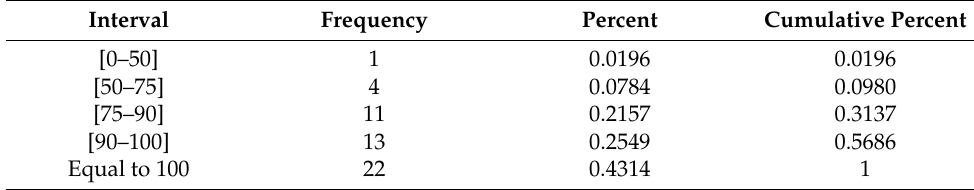
Table 5. International